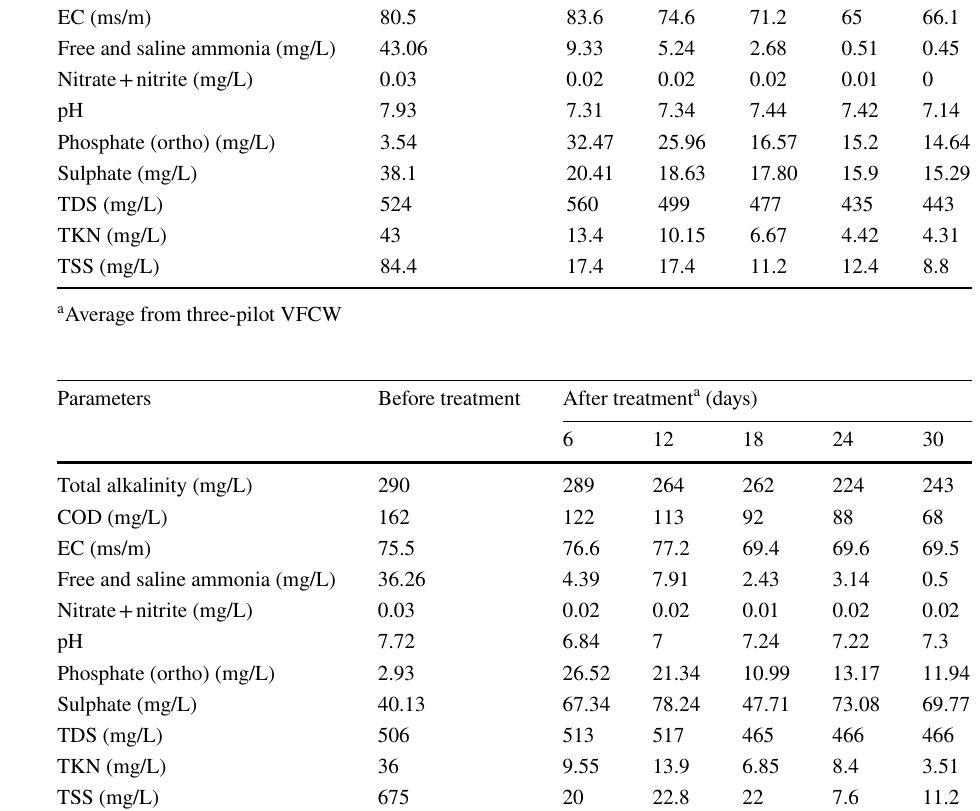
a Average from three-pilot